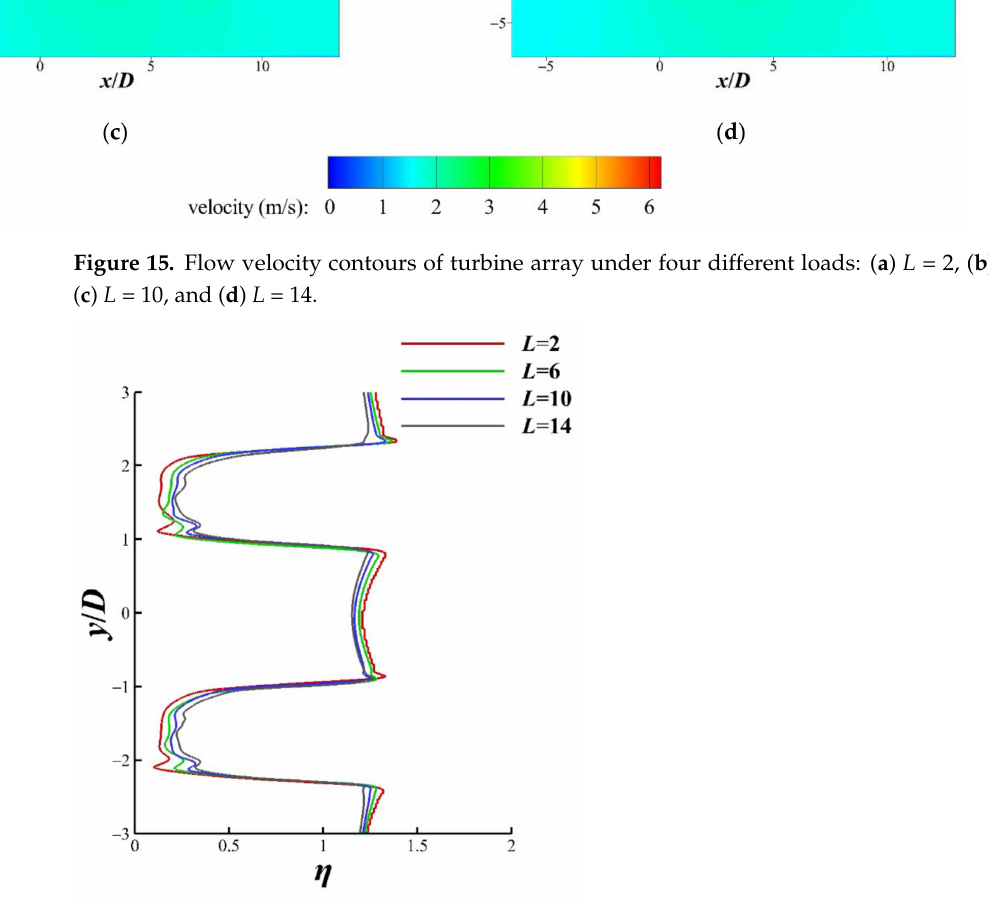
Figure 16. Velocity radial deficit at x =